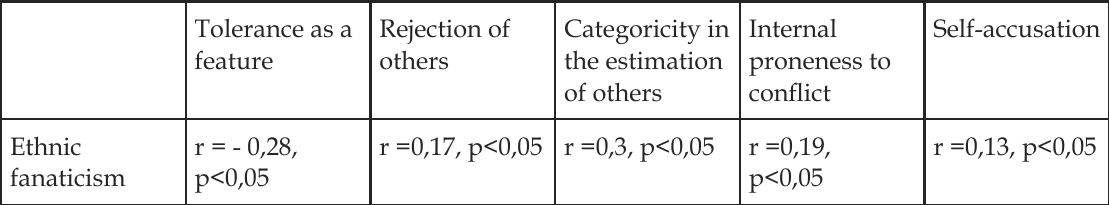
Tab. 4. The correlation of ethnic fanaticism with the scales of tolerance and